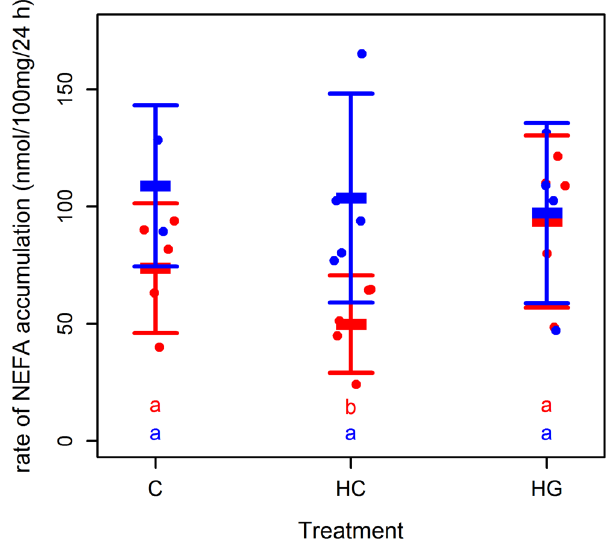
Figure 4. Effect of glucose and hydrocortisone on NEFA accumulation in media from grey seal blubber explants. NEFA accumulation ( Δ NEFA 24 h − 1 100 mg − 1 ) by 100 mg blubber tissue explants from grey seals (n = 10). Each point represents one animal (red = female; blue = male). Bars represent mean ( ± s.d.). Tissues were minced and incubated in DMEM with 10% fetal bovine serum 5% penicillin and streptomycin, and glutamine. Explants from the same animal were supplemented with 5.5 mM glucose (C), 25 mM glucose (HG) or 5.5 mM glucose + 500 nM hydrocortisone (HC). Media was harvested after overnight (24 h) incubation. Different letters indicate where treatments were significantly different from each other (LME: p < 0.05).